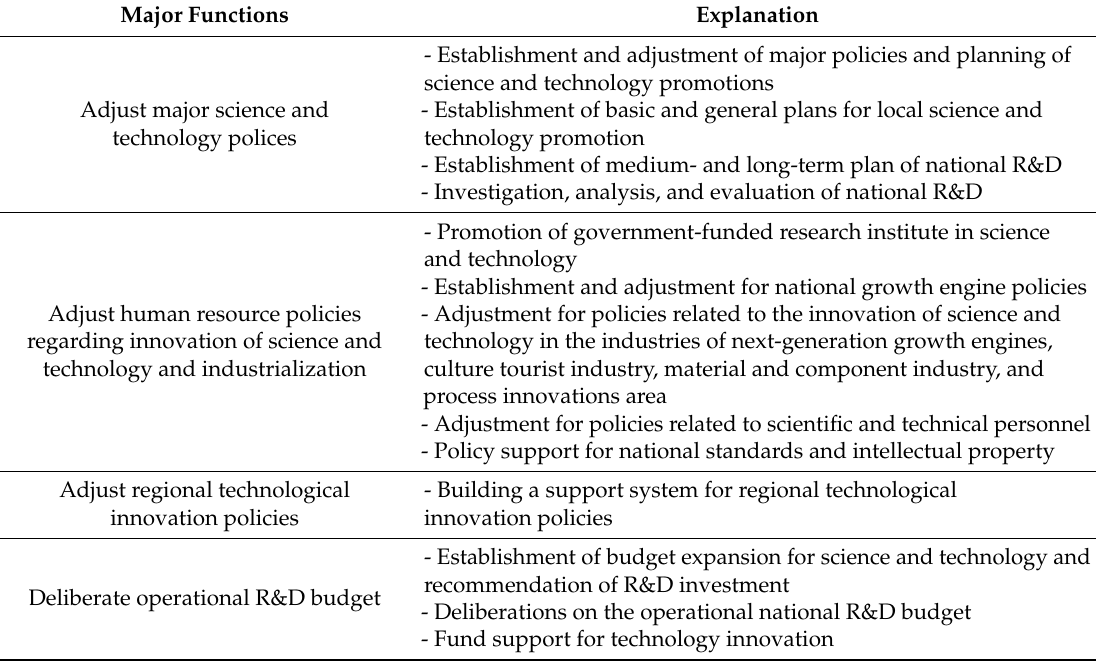
Table 2. Major functions of the NSTC.